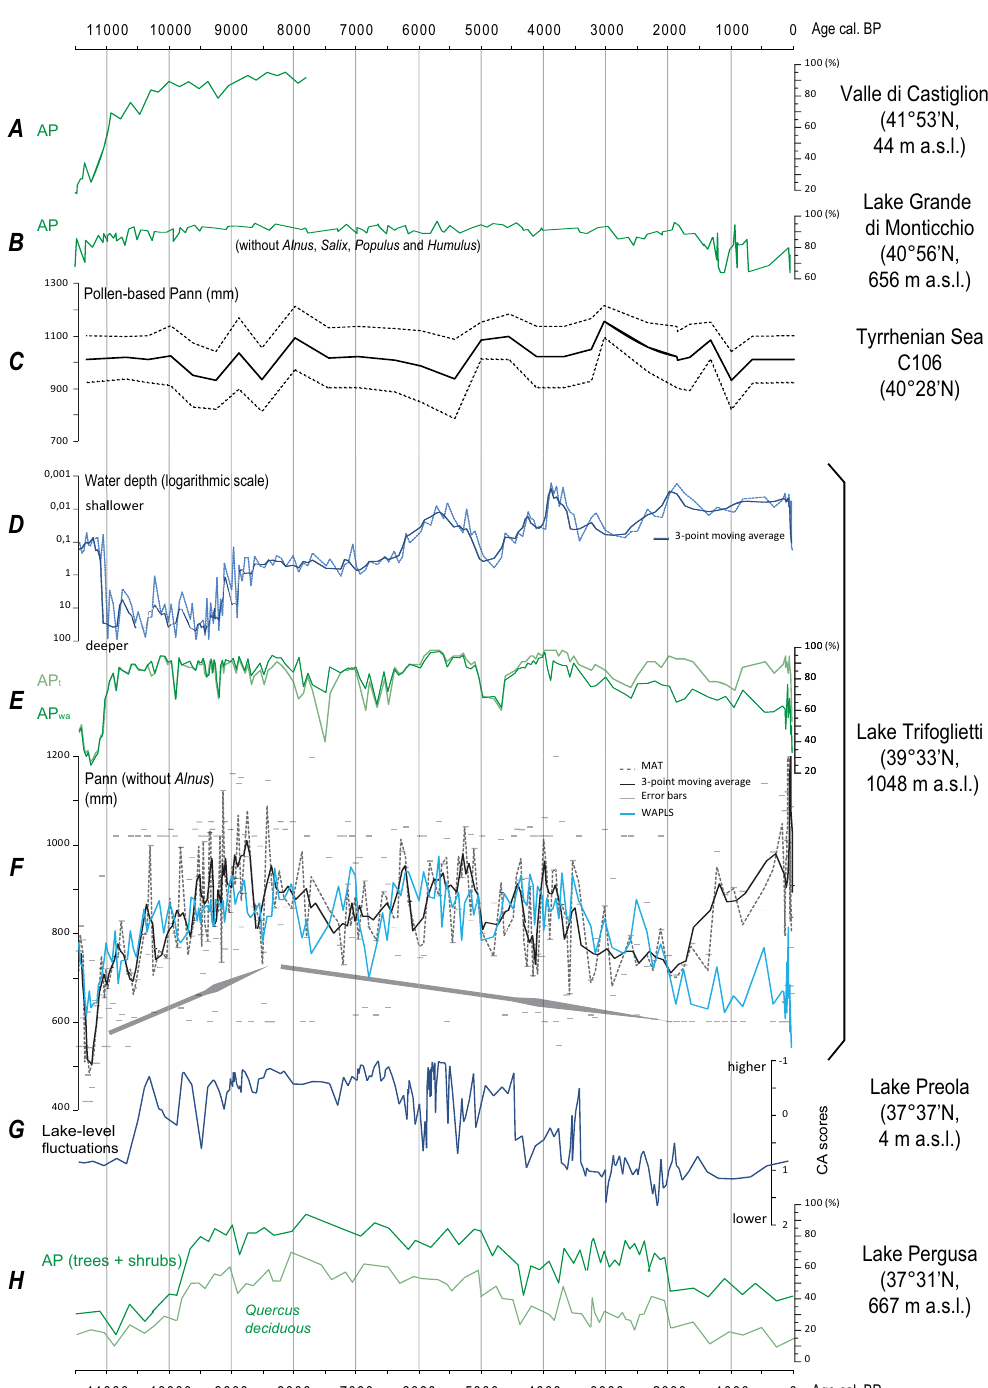
Fig. 9. Comparison of paleorecords from Valle di Castiglione (A; Di Rita et al., 2012), Lake Grande di Monticchio (B; AP changes; Allen et al., 2002), C106 marine core [C; pollen-based annual precipitation (Pann); Di Donato et al., 2008], Lago Trifoglietti [D, pollen-based water-depth; E, AP t and AP wa (Arboreal Pollen total or Without Alnus ); F, pollen-based annual precipitation (Pann) using MAT and WAPLS methods], Lake Preola (G; lake-level changes; Sicily, Magny et al., 2011b) and Lake Pergusa (H; AP changes and deciduous Quercus ; Sicily, Sadori et al.,